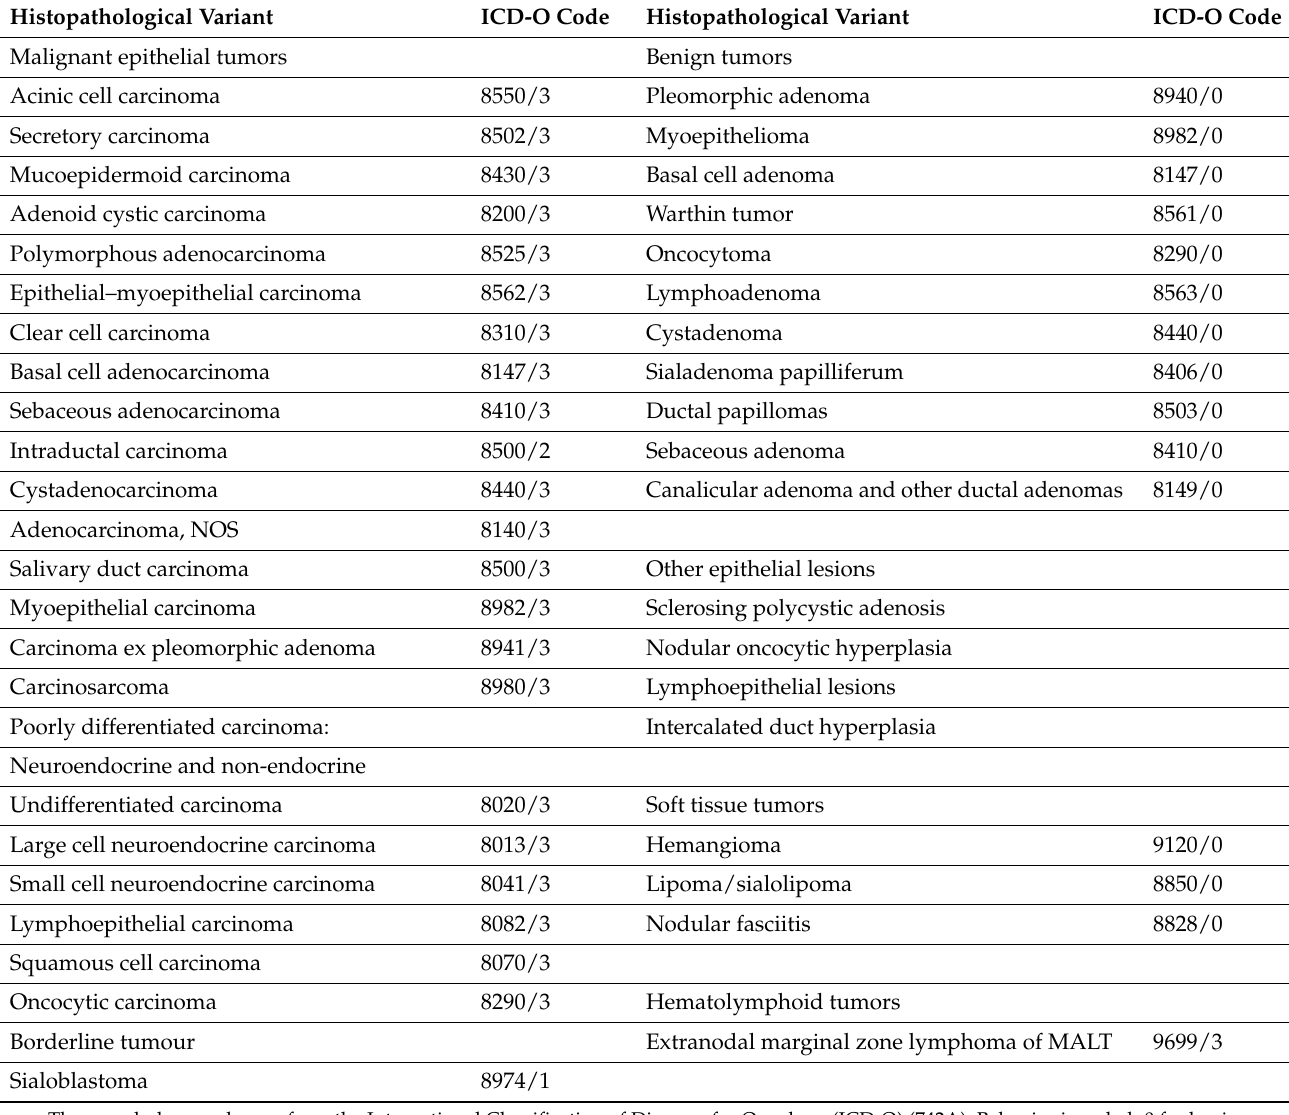
Table 1. WHO classification of SGN (2017). Reprinted from [15] with